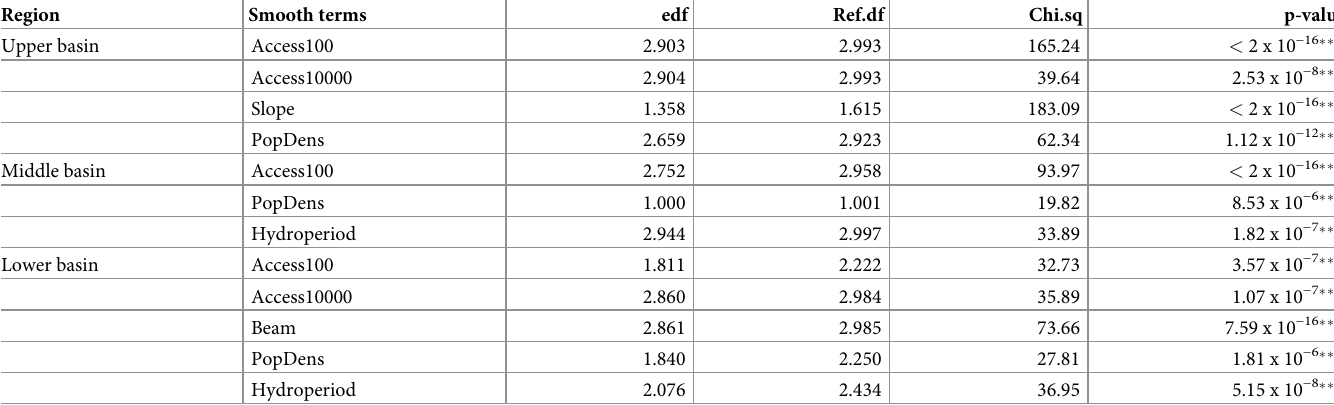
Table 3. Results from generalised additive models. GAM models including the most relevant variables as defined by partial deviance. Region Smooth terms edf Ref.df